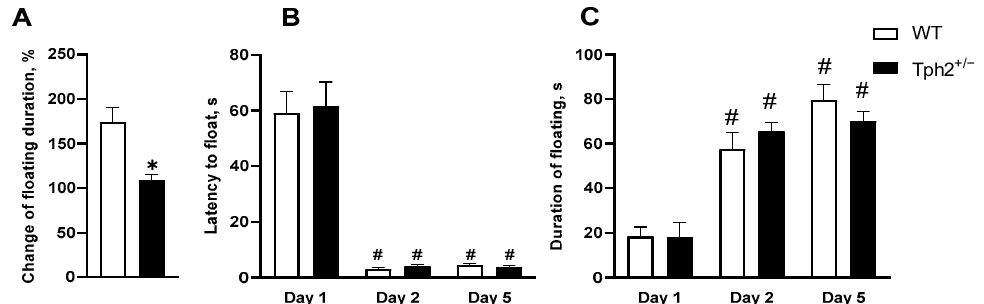
Figure A3. Floating behavior in the modified swim test. ( A ) A smaller increase in floating duration from day 2 to day 5 was observed in the Tph2 +/ − mice compared to WT. ( B ) A significant decrease in latency to float on days 2 and 5 compared to day 1 was observed and was independent of genotype.